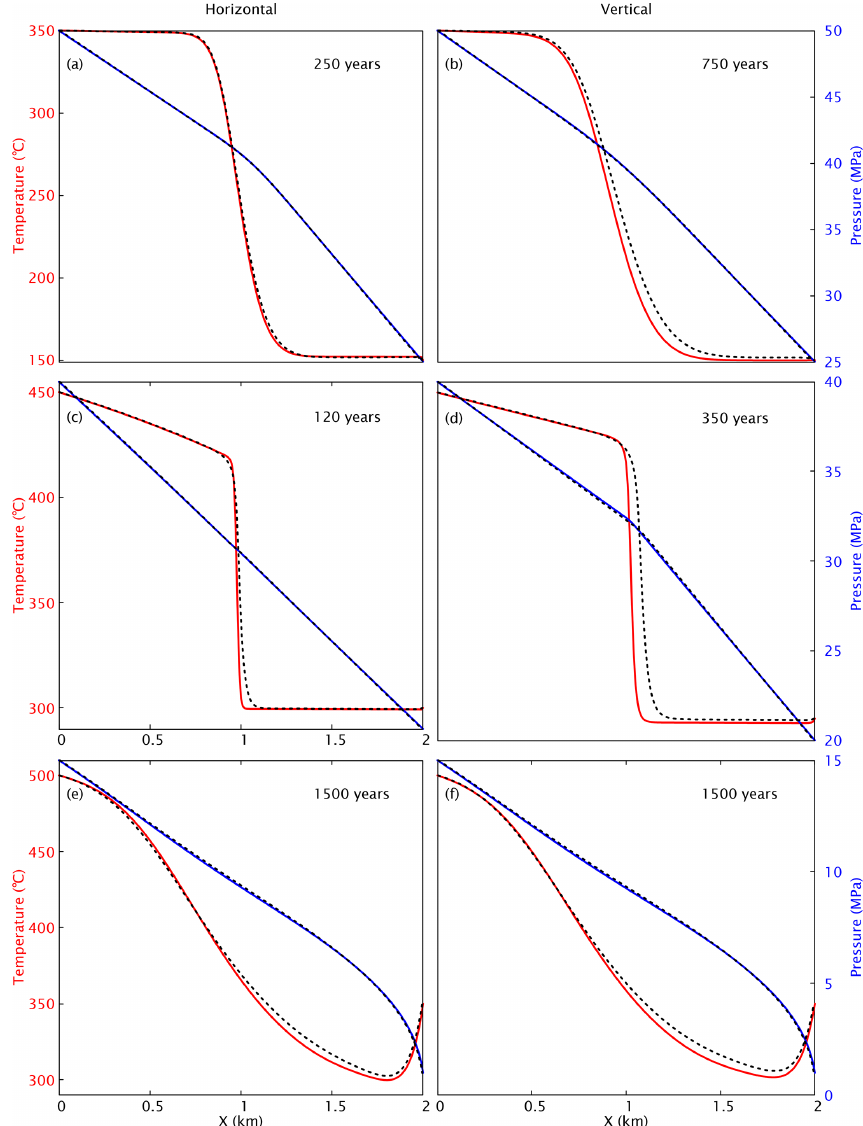
Figure 5. Snapshots of one-dimensional benchmark examples in horizontal (a, c, e) and vertical (b, d, f) orientation. Results (temperature in red and pressure in blue) of HydrothermalFoam and HYDROTHERM are plotted as solid lines and dashed lines, respectively.